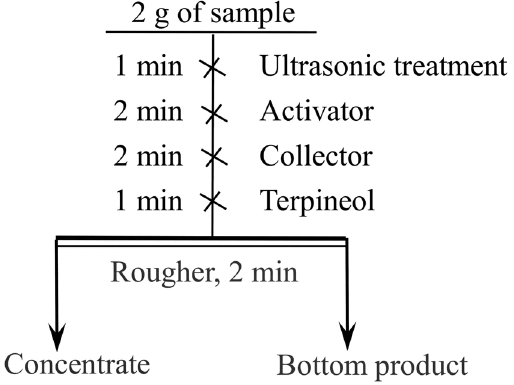
Figure 2. Experimental schematic of the